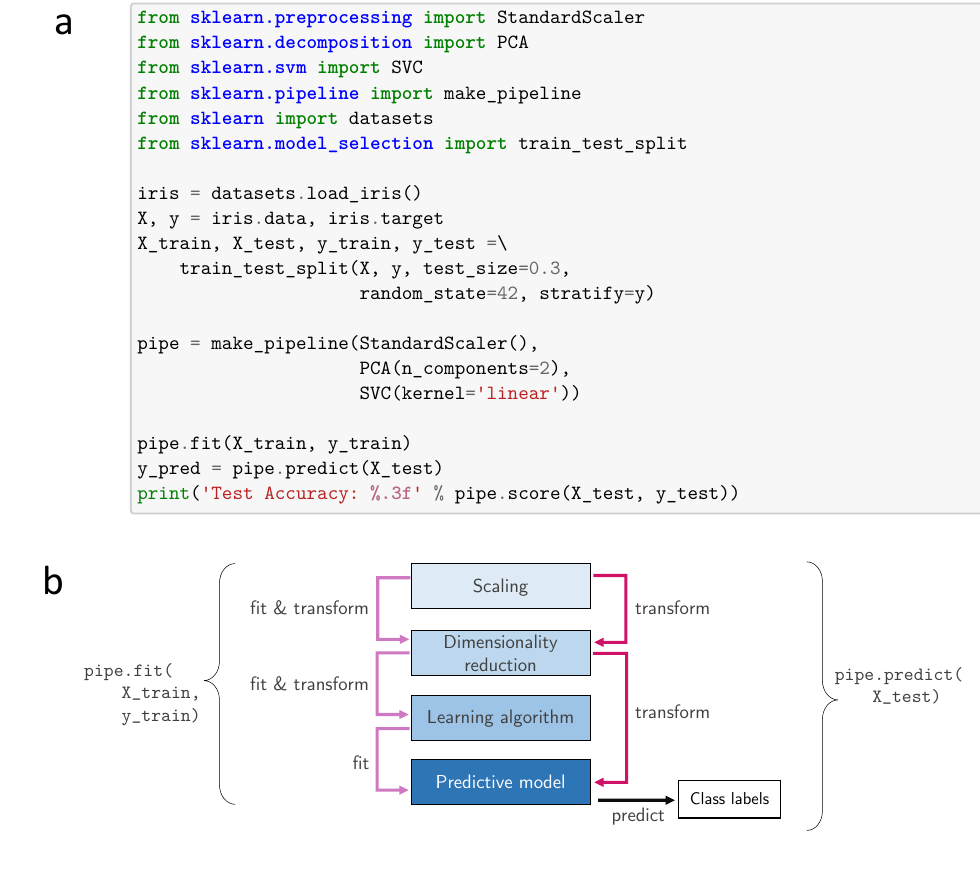
Figure 2. Illustration of a Scikit-learn pipeline. ( a ) code example showing how to fit a linear support vector machine features from the Iris dataset, which have been normalized via z-score normalization and then compressed onto two new feature axes via principal component analysis, using a pipeline object; ( b ) illustrates the individual steps inside the pipeline when executing its fit method on the training data and the predict method on the test